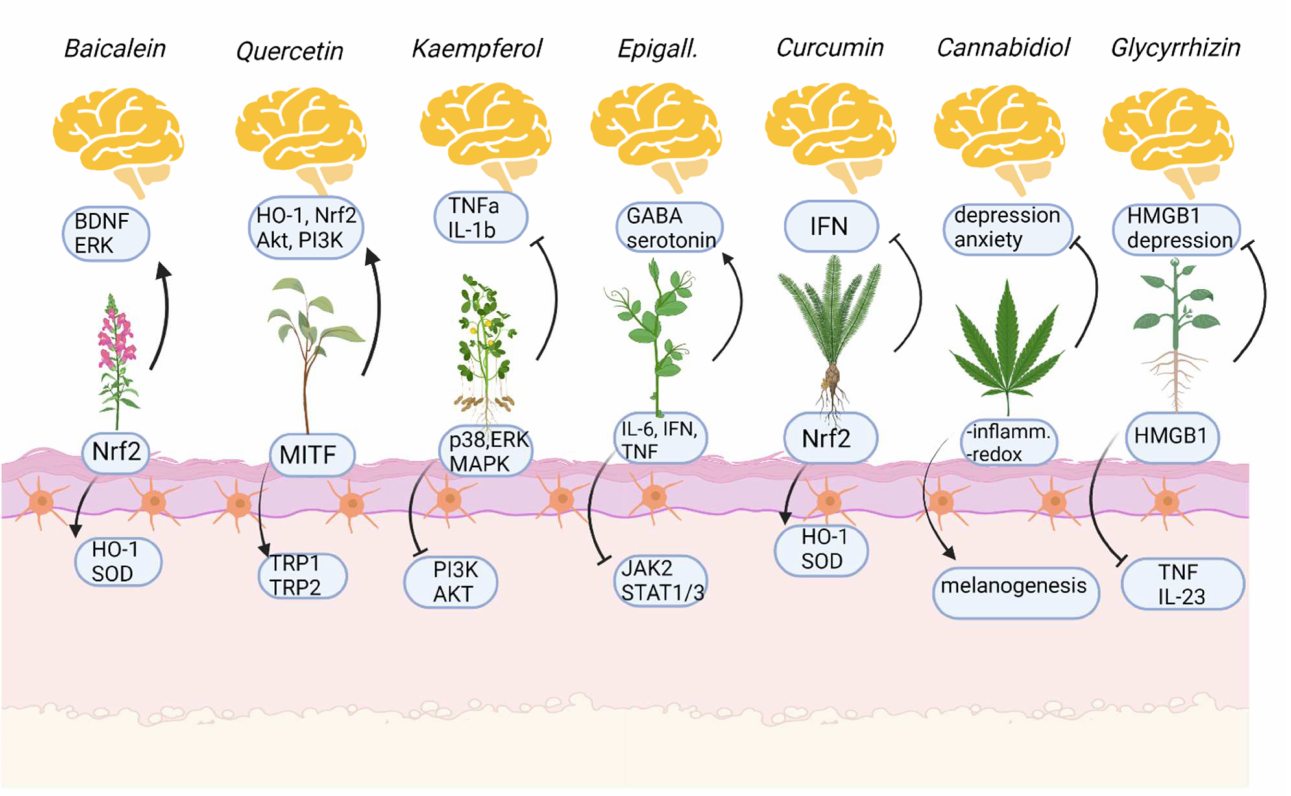
Figure 3. Mechanism of action of natural compounds on the skin (below, melanocytes) and on mental health issues (above). Arrows indicate activation, stops indicate inhibition. Created with BioRender.com (accessed on 1 November 2022).